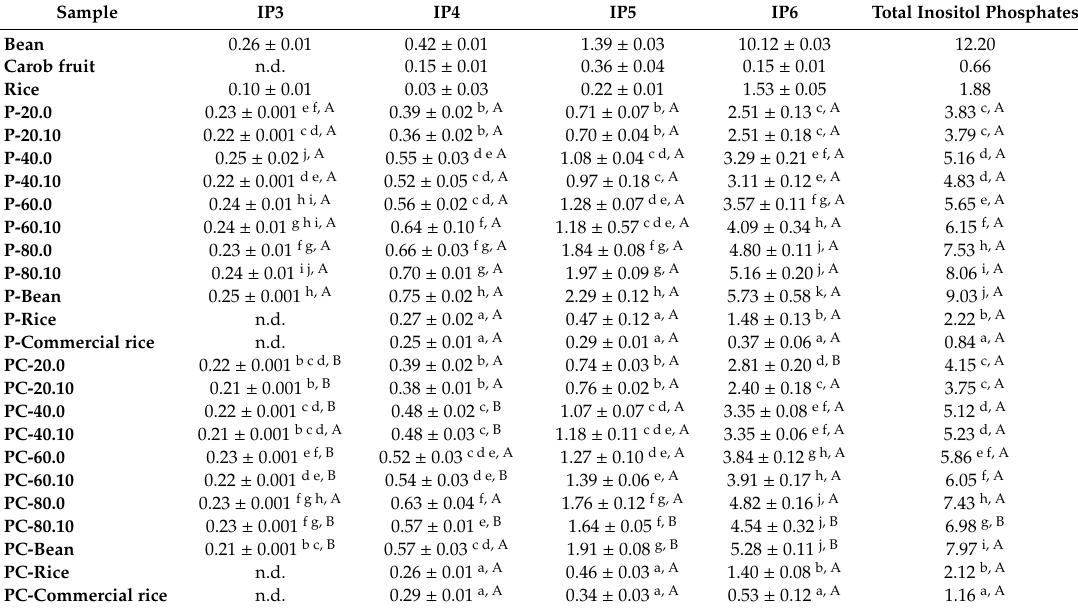
Table 2. Inositol phosphates content (mg / g dry weight) of the raw materials and the di ff erent uncooked (P-) and cooked (PC-) fettuccine pastas and the commercial rice